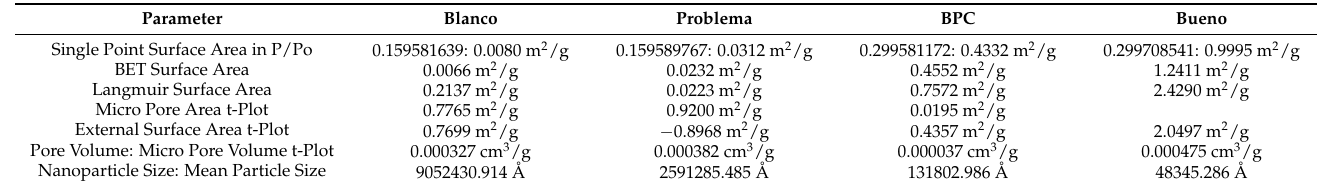
Table 4. Analysis of surface area and porosity of KCl mineral